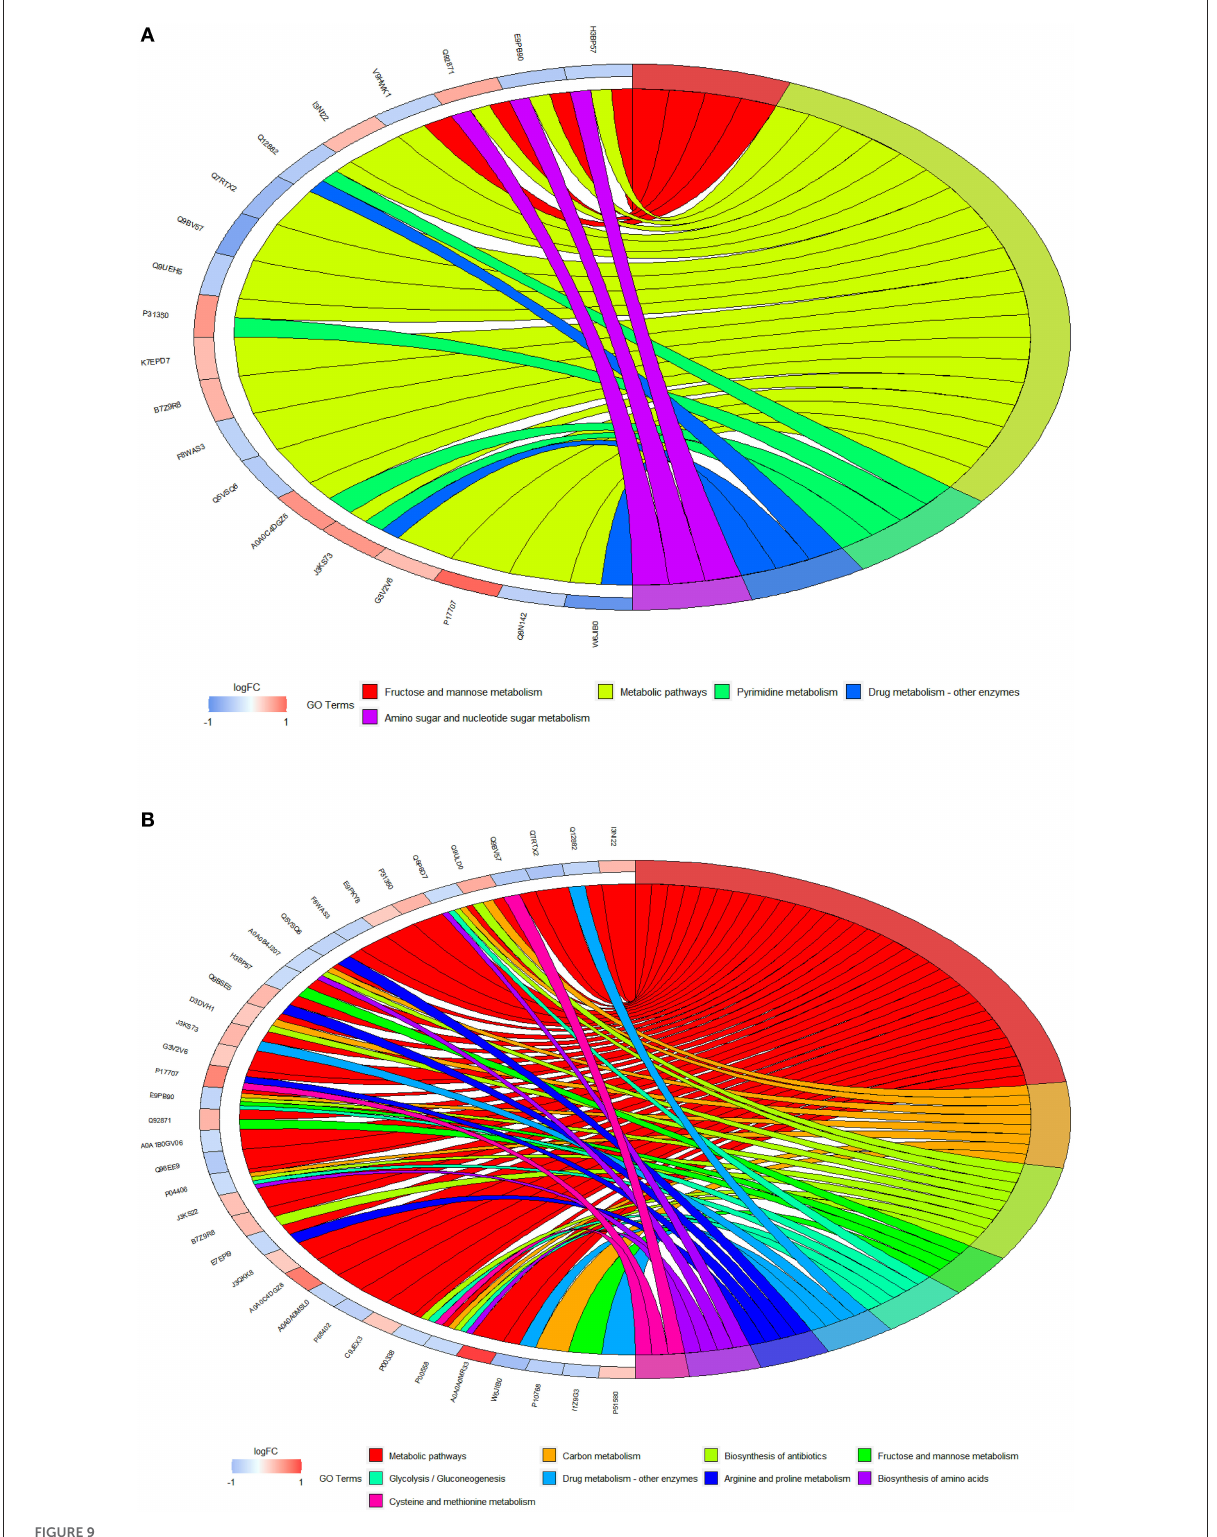
FIGURE9 (A) The GO chord diagrams of differential proteins between control (0 mg/L phosphate residue) and fish sausage group (0.13 mg/L phosphate residue); (B) is the GO chord diagrams of differential proteins between control (0 mg/L phosphate residue) and positive control group (1 mg/1L phosphate